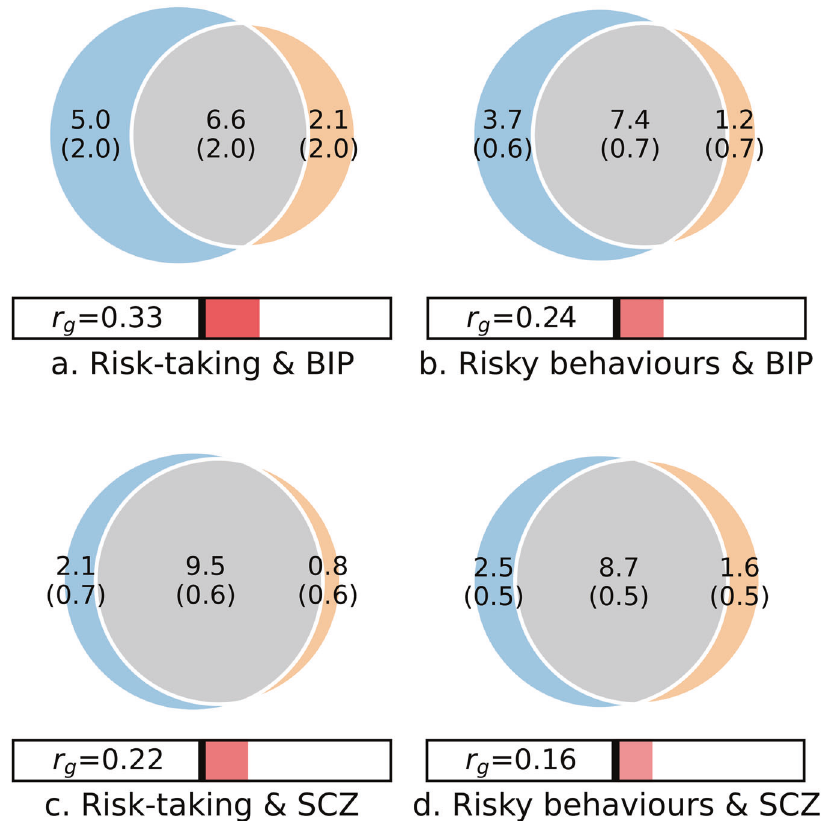
Fig. 1 Genome-wide genetic overlap between risk phenotypes, bipolar disorder and schizophrenia. MiXeR analysis for a bipolar disorder (BIP) and risk-taking, b BIP and risky behaviours, c schizophrenia (SCZ) and risk-taking, and d SCZ and risky behaviours. Venn diagrams representing the unique and shared variants associated with risk-taking and risky behaviours and each of SCZ and BIP. Polygenic overlap is represented in grey, Risk/risky behaviours in blue and BIP/SCZ in orange. The numbers indicate the estimated quantity of variants in thousands per component that explains 90% of SNP heritability for each phenotype (standard error in parentheses). The size of the circle re fl ects the extent of polygenicity for each